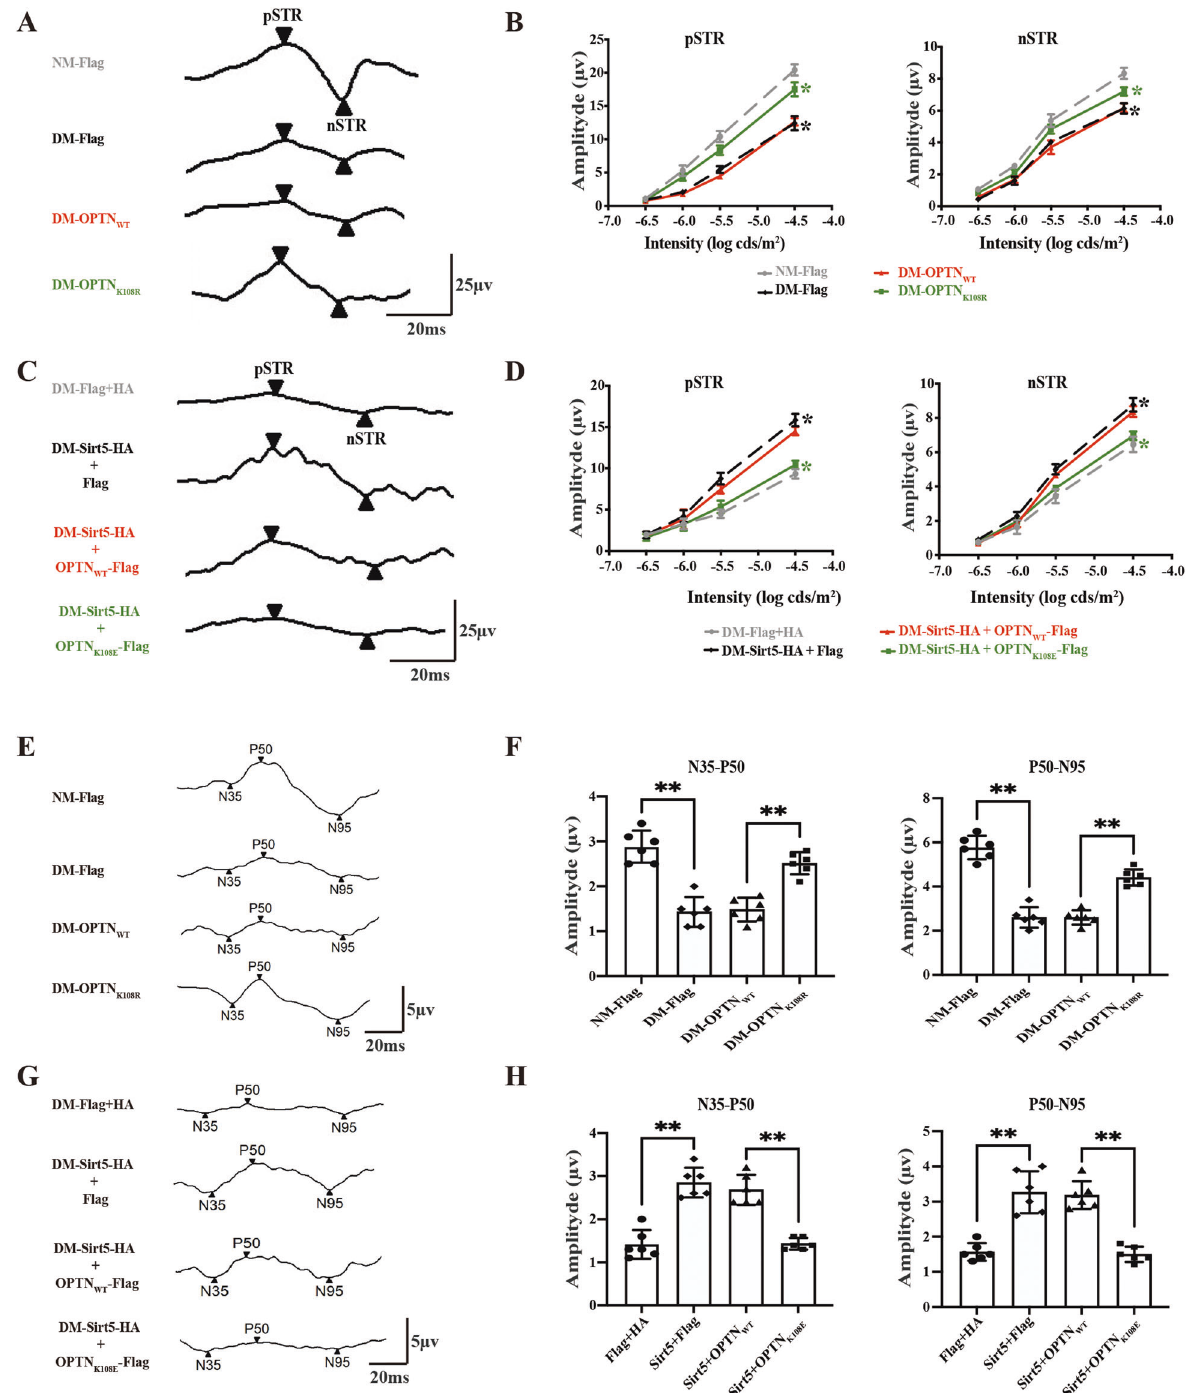
Fig. 7 The Sirt5-OPTN K108 su axis improves RGCs function in STZ-induced diabetic rats. A , B Stimulus intensity responses for the STR, showing the pSTR and nSTR in rats whose eyes were injected with OPTN-WT, OPTN-K108R or scrambled lentivirus. Representative images ( A ) and quantitative data ( B ) are provided. Absolute amplitude appears on the y-axis, and the 4 fl ash intensities (log cds/m 2 ) are on the x-axis. A description of the data points appears at the bottom of the graph. Green * p < 0.05 between LV.OPTN K108R - and LV.OPTN WT -injected groups; black * p < 0.05 between DM and NM retinas subjected to LV.Flag. C , D pSTR and nSTR in rats subjected to eye injection of LV.Sirt5 and OPTN- WT, OPTN-K108E or scrambled lentivirus. Representative images ( C ) and quantitative data ( D ) are provided. Green* indicates p < 0.05 between the LV.Sirt5 + OPTN K108E - and LV.Sirt5 + OPTN WT -injected groups. Black* indicates p < 0.05 between the LV-Sirt5 + Flag and scrambled LV.HA + Flag groups. E , F PERG in rats subjected to eye injection of OPTN-WT, OPTN-K108R or scrambled lentivirus. Representative images ( E ) and quantitative data ( F ) are provided. G , H PERG in rats subjected to eye injection of LV.Sirt5 and OPTN-WT, OPTN-K108E or scrambled lentivirus. Representative images ( G ) and quantitative data ( H ) are provided. The data are shown as the mean ± SD ( n = 6). * p < 0.05. ** p < 0.01. STR scotopic threshold response, pSTR/nSTR positive STR and negative STR, PERG pattern